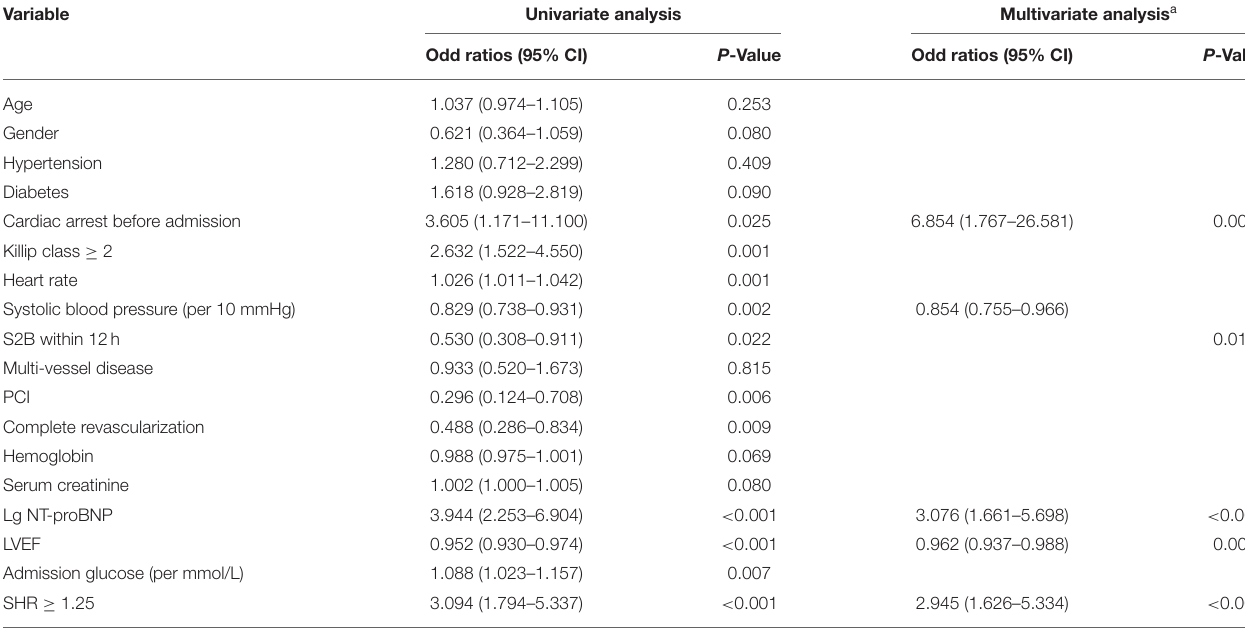
TABLE 3 | Univariate and multivariate logistic regression analysis for in-hospital